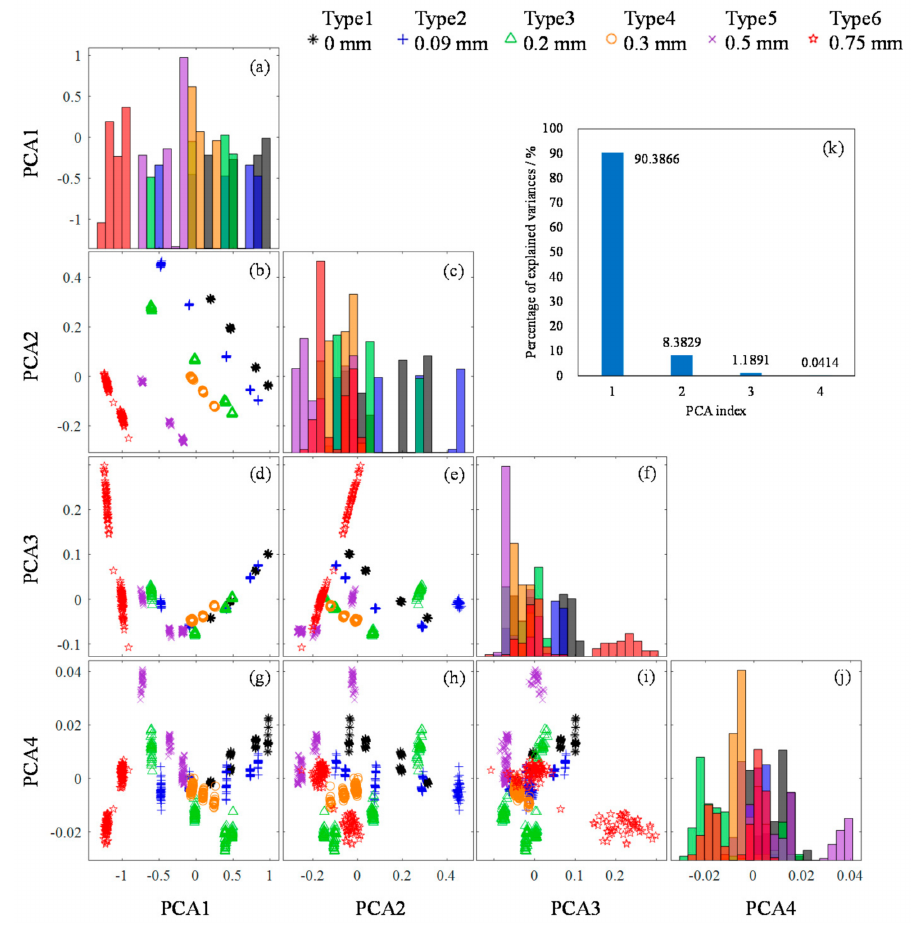
Figure 11. Analysis result of PCA. The matrix diagram of PCA is composed of ( a – j ). In the matrix of scatter plots ( b , d , e , g – i ), the horizontal and vertical coordinates are the pairwise combinations of PCA1, PCA2, PCA3, and PCA4 respectively. The diagonal plots are histograms ( a , c , f , j ), indicating the distribution on a separate variable of PCA1, PCA2, PCA3, PCA4 respectively. The color of each data depends on the types of faults. The histogram ( k ) shows the contributing rate of PCA